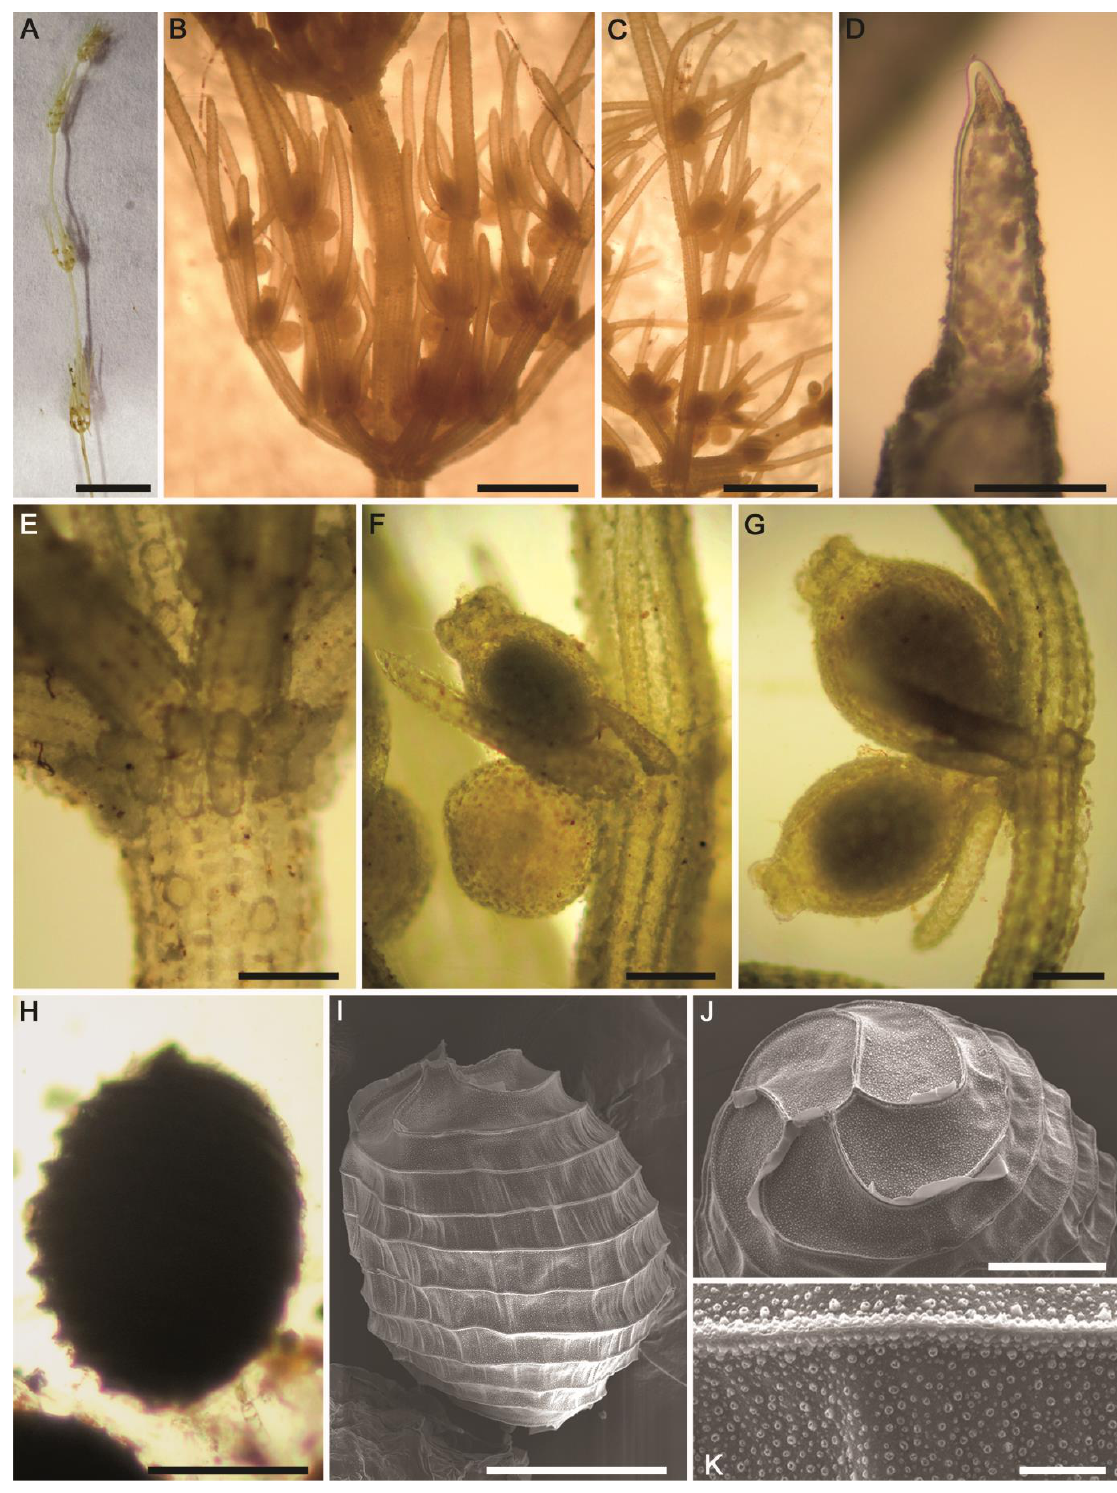
Figure 7. Morphotaxonomic features of Chara contraria found in an agricultural ditch in the El-Dakhla Oasis (the Western Desert of Egypt): ( A ) macroscopic habitus; ( B ) whorl of branchlets; ( C ) branchlet; ( D ) terminal branchlet cell; ( E ) axial node showing stipulodes and spine-cells; ( F , G ) nodes of branchlets showing oogonia and antheridia. Oogonia might be geminate. ( H ) Oospore; ( I ) SEM of the oospore; ( J ) apical part of the oospore, SEM; ( K ) close-up SEM view on the oospore wall showing granulate ornamentation covering the fossa and the ridges. Scale bars: ( A ) = 1 cm; ( B , C ) = 2 mm; ( E – I ) = 200 μ m; ( D , J ) = 100 μ m; ( K ) = 10 μ m.